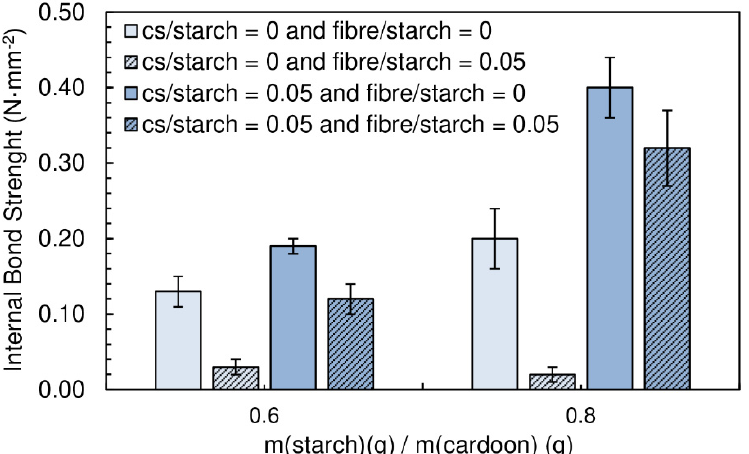
Figure 7. Effect of fiber content and the combined effect of chitosan and fiber on internal bond strength of the particleboards bonded with a potato starch. All adhesive formulations had a starch/cardoon ratio of 0.6 and 0.8.